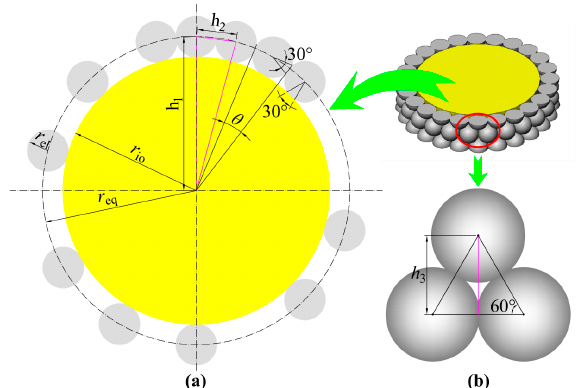
Figure 4. The schematic illustration of geometric relations in the repeating unit. ( a ) the define of crucial parameters. ( b ) the define of h 3